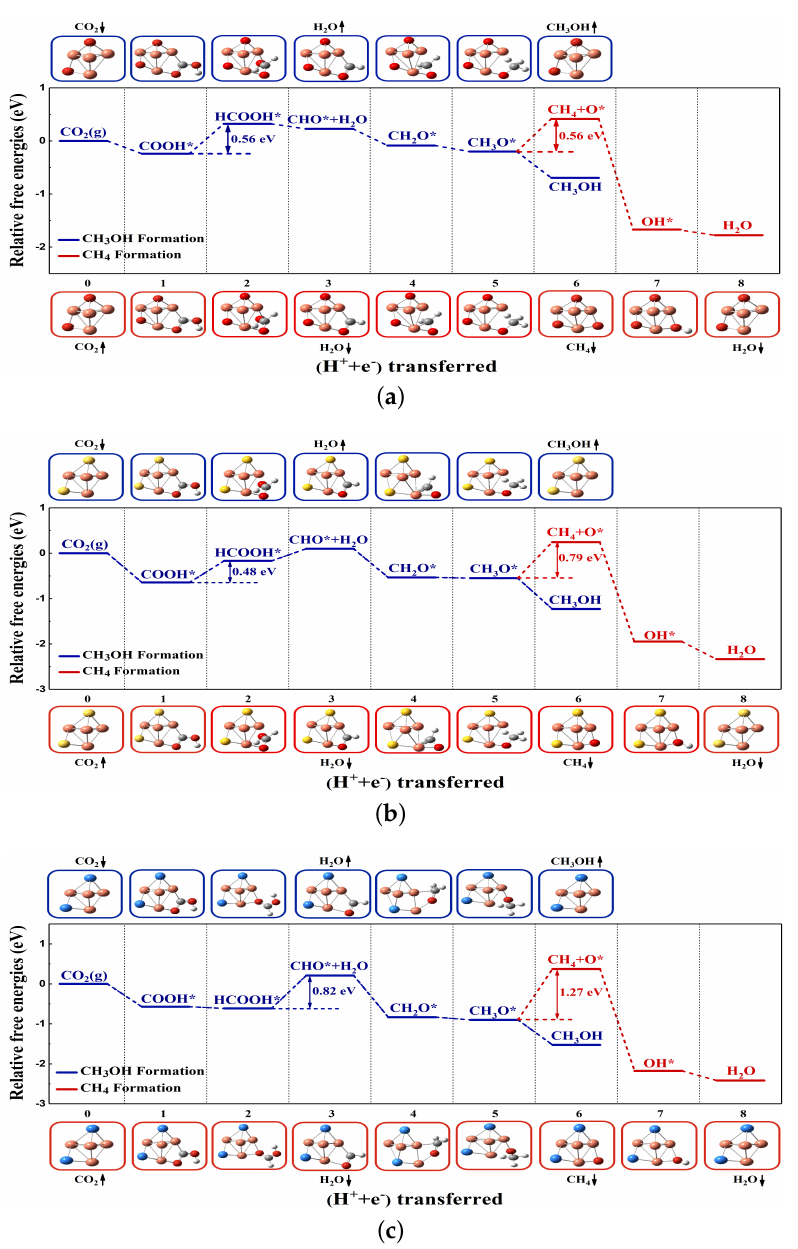
Figure 1. The lowest free energy diagram of CO 2 RR to CH 3 OH and CH 4 with no applied potential on Cu 4 O 2 ( a ), Cu 4 S 2 ( b ), and Cu 4 Se 2 ( c ) clusters. (The blue line represents the methanol formation pathway, with the intermediate products shown in the upper part of the figure. The red line represents the methane formation pathway, with the intermediate products shown in the lower part of the